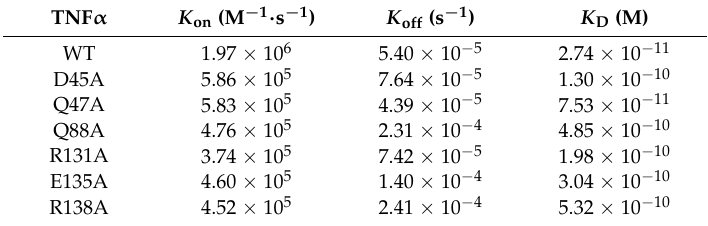
Table 1. Binding kinetics of the TNF α mutants with certolizumab Fab fragments. WT: Wild-type.